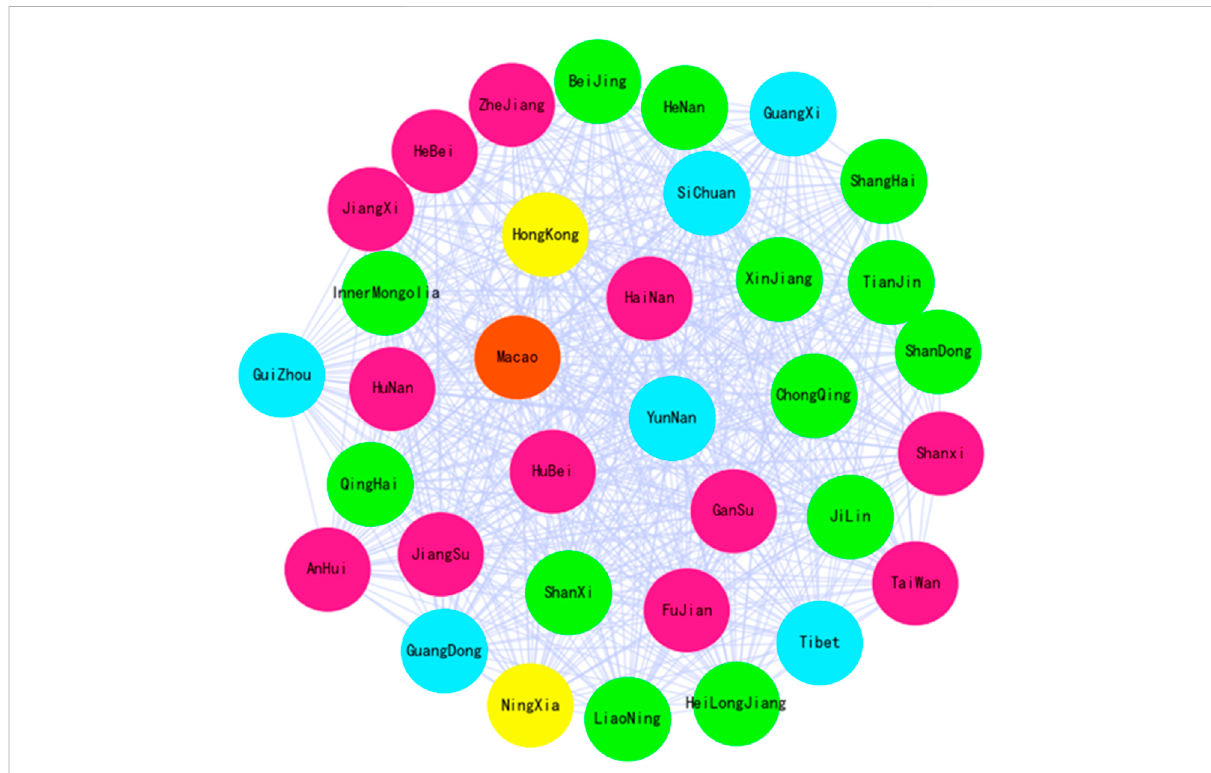
FIGURE 8 Cluster graph shows nodes representing China ’ s provincial administrative regions. The node colour indicates the category of the provincial administrative region. There are fi ve categories, and the same colour indicates that these provincial administrative regions are classi fi ed as the same category according to their